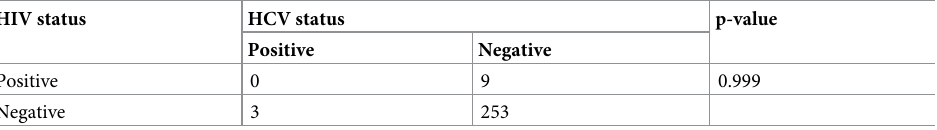
Table 6. HIV and HCV co-infection among HBsAg positive delivering mothers in governmental hospitals in Addis Ababa,